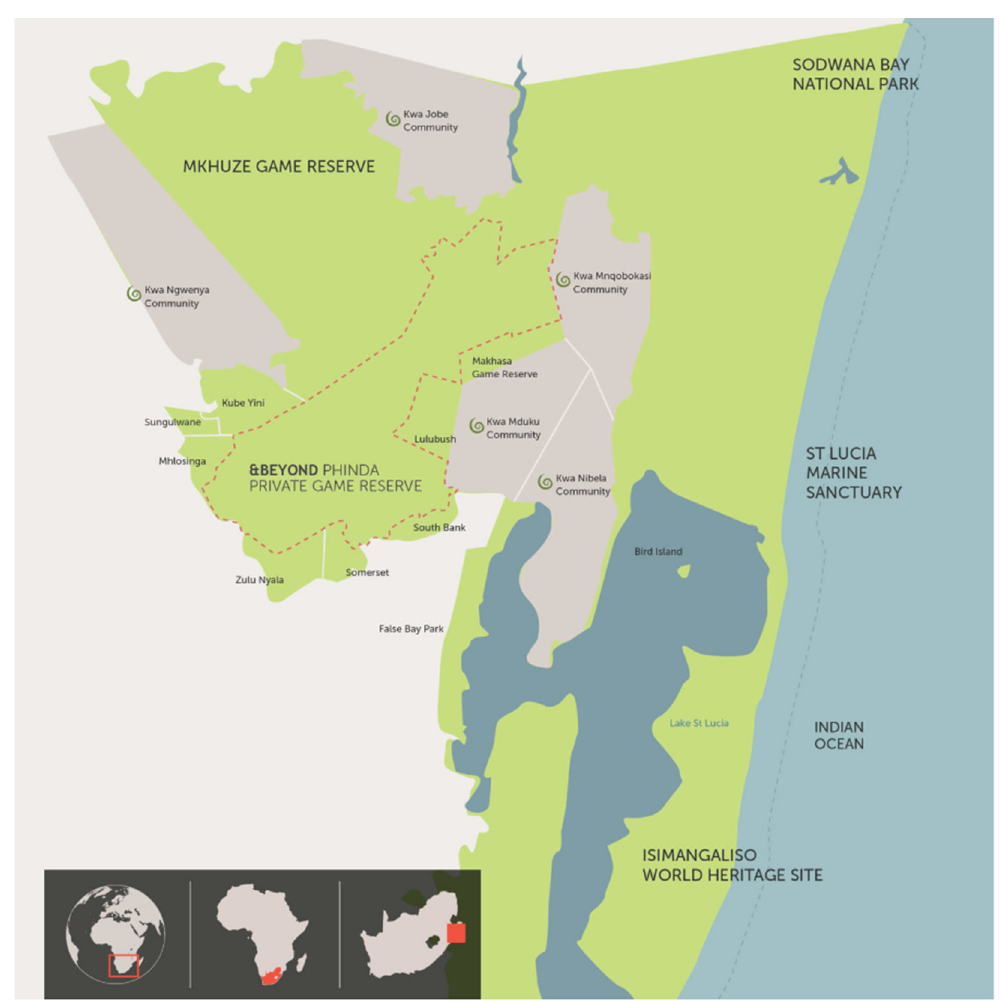
Figure 1. Phinda Private Game Reserve, KwaZulu ‐ Natal Province, South Africa. Source: Image Supplied by andBeyond.